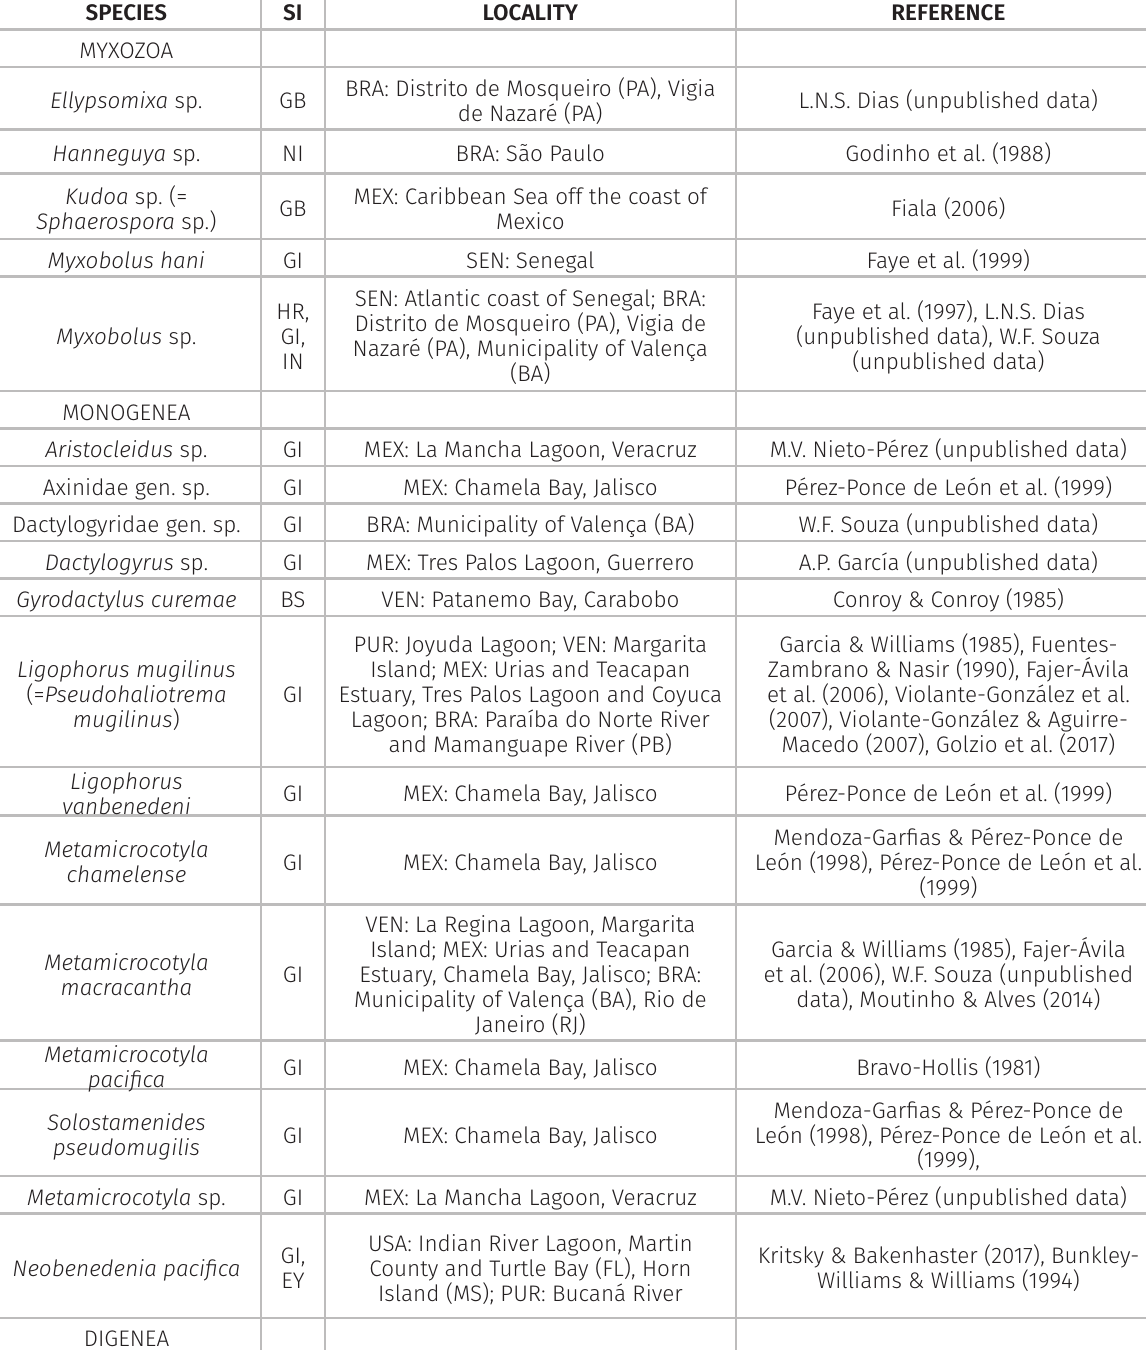
Table I. Occurrence list of all parasites in M. curema : SI (infection/infestation sites), OC (opercular cavity), GI (gills), BS (body surface), EY (eyes), HR (heart), ST (stomach), LI (liver), IN (intestine), MS (muscle), VO (visceral organs), GB (Gallbladder), NI (not